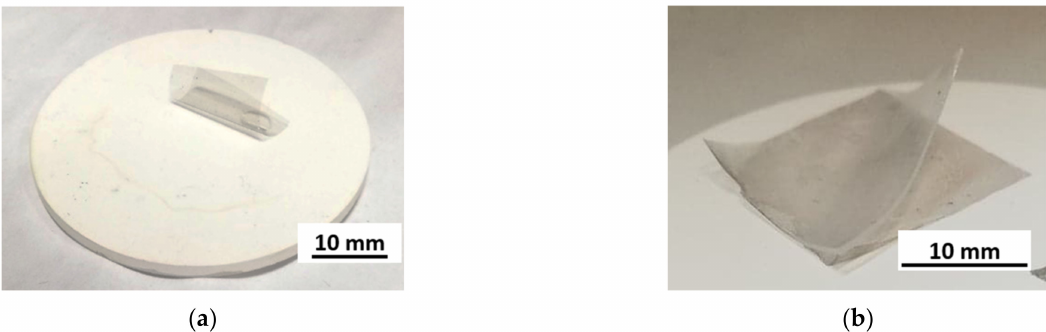
Figure 6. Al 2 O 3 ceramic surface during HSMG ® graphene transfer sample: ( a ) without surface modification—lack of graphene–PMMA adhesion to the surface; ( b ) with surface modification— graphene adheres to the surface of ceramics; delamination of an additional PDMS layer during removal of the PMMA support layer in alcohol